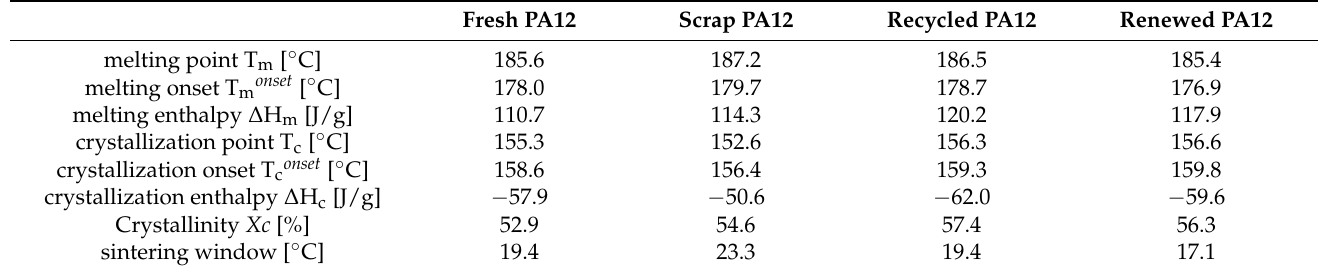
Figure 8. DSC thermograms of PA12 samples: fresh PA12, scrap PA12, recycled PA12, and re- newed PA12. Table 5. Quantitative data of thermal properties for PA12 samples.